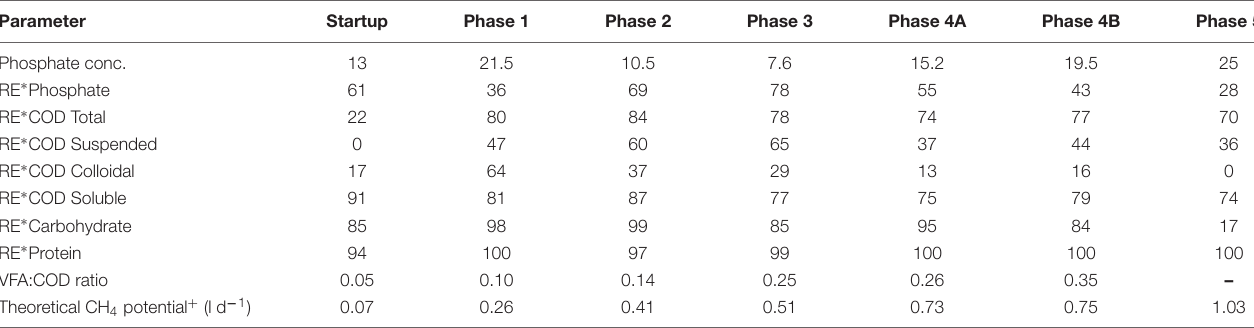
TABLE 3 | Average Phosphate concentration (in mg l − 1 ) and average Phosphate, COD Tot , COD Sus , COD Col , COD Sol , Carbohydrate, Protein, and removal efficiency (RE) (%) in reactor effluent and the VFA:COD ratio for the five phases of reactor operation. Parameter Startup Phase 1 Phase 2 Phosphate conc.